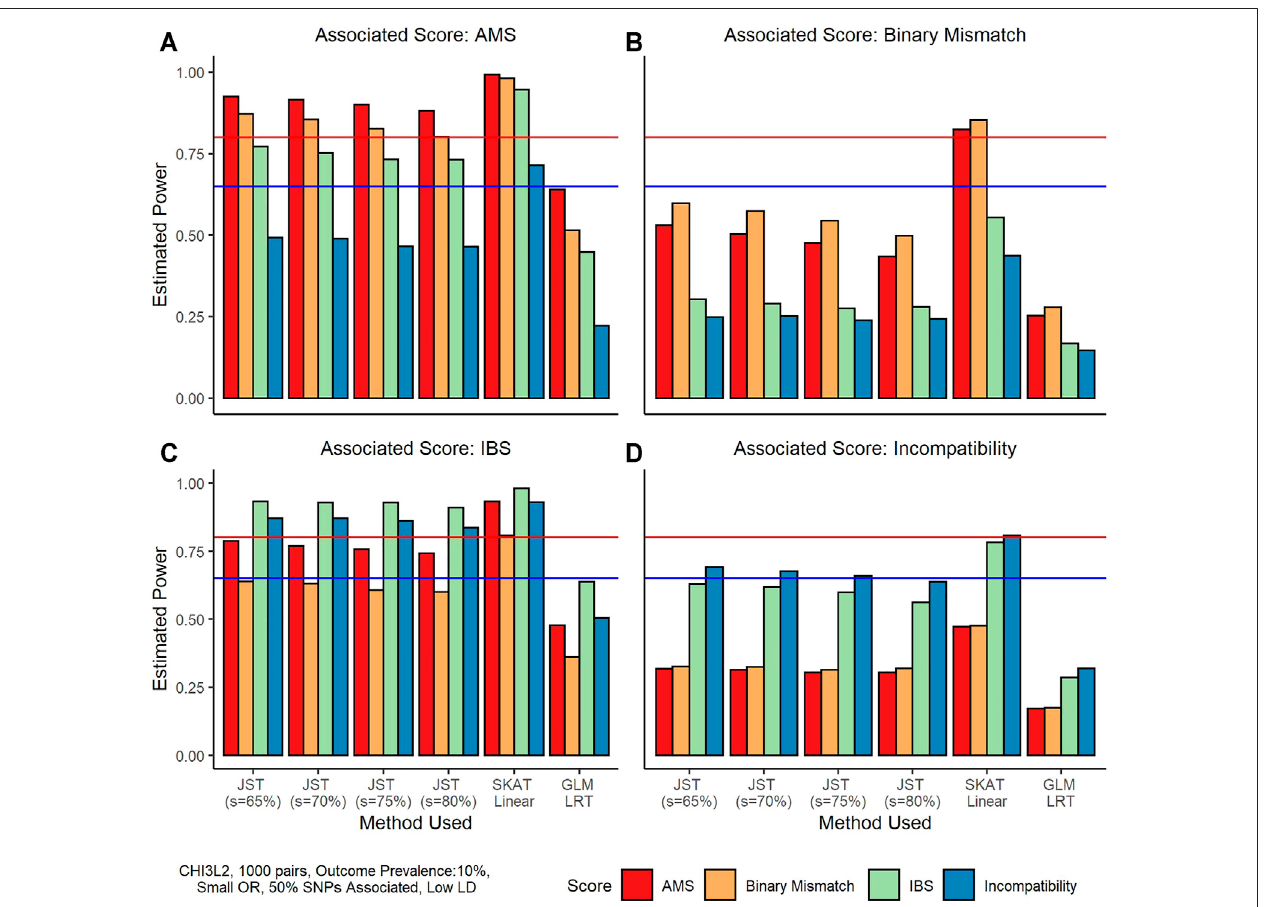
FIGURE2| Powerestimates from simulations using the gene CHI3L2 and 1,000pairs ofdonors and recipientsunderthe scenario thatthe gene-based scorewas associated with outcome. All plots shown are for a binary outcome with prevalence 10%. A small odds ratio (1.25) was used for phenotype generation. For these simulations,50%ofSNPsinthegenescorewereassociatedwiththeoutcome,andtheseSNPswereinlowLD.Fromlefttoright,andtoptobottomthetrueassociated gene-score is the allogenomics mismatch score (AMS), the Binary Mismatch, the identity-by-state (IBS), and the Incompatibility score. The four colors represent whichscorewasusedto fi tthemodel,whereredistheAMS,yellowistheBinary Mismatchscore,greenistheIBS,andblueistheIncompatibilityscore.Ineachplot,the x-axis corresponds to the method used, where from left to right methods are joint score test (JST) with s values of 65, 70, 75, and 80% of variance explained by the principal components used, the sequence kernel association test (SKAT) with unweighted linear kernel, and a generalized linear model (GLM) likelihood ratio test (LRT). The y-axis shows estimated power from 0 to 100%. The horizontal blue line corresponds to 65% power and the horizontal red line corresponds to 80% power.